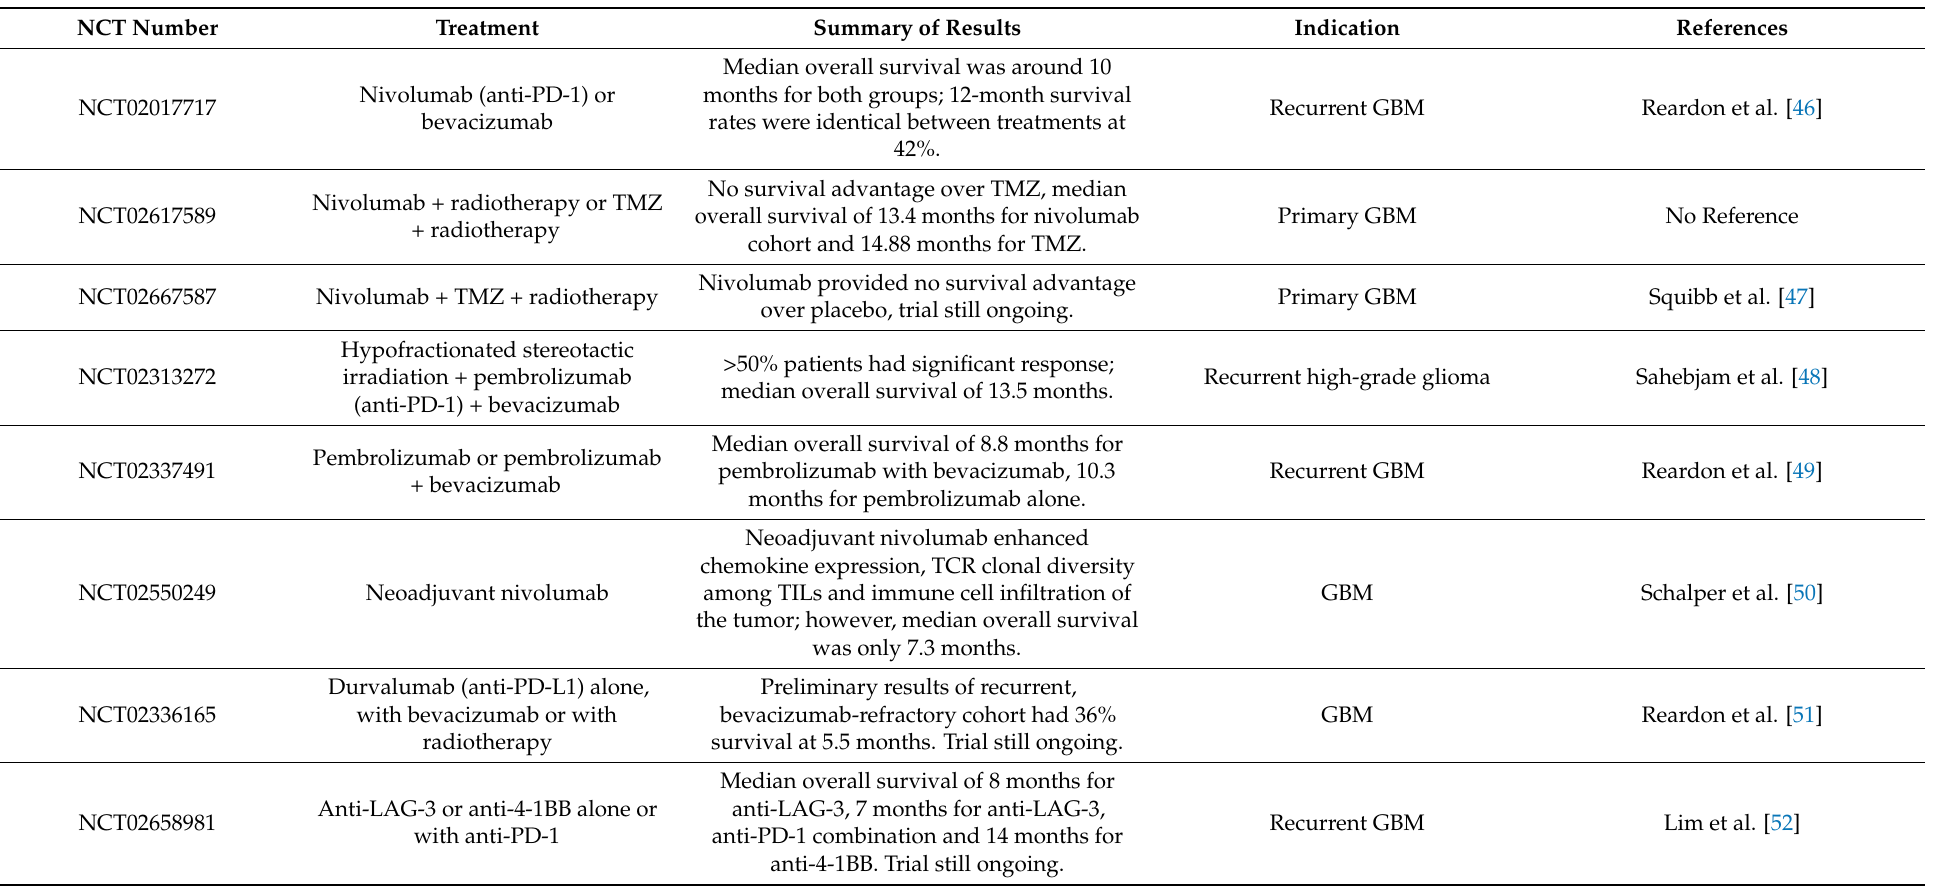
Table 2. Summary of clinical trials for immune checkpoint inhibitors against